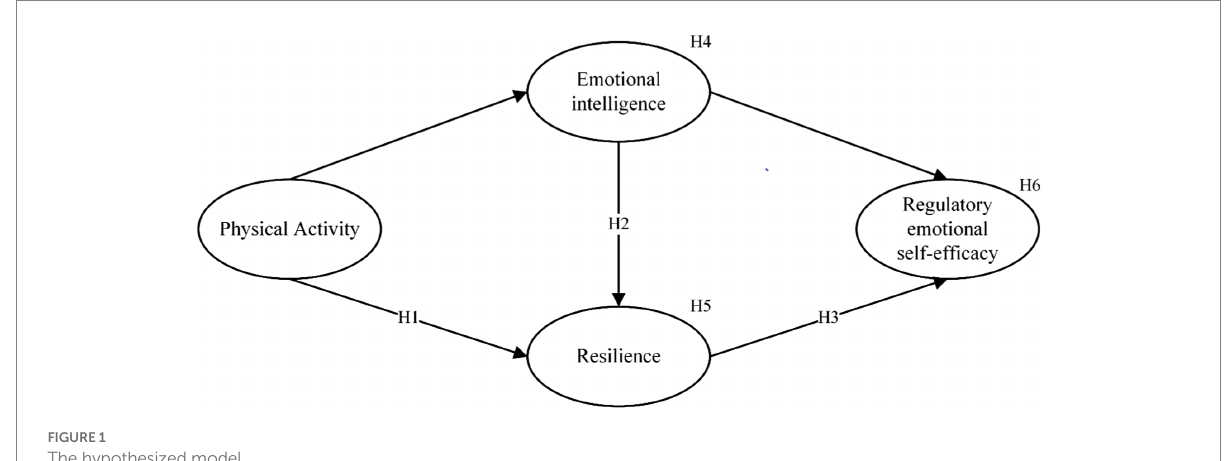
FIGURE 1 The hypothesized